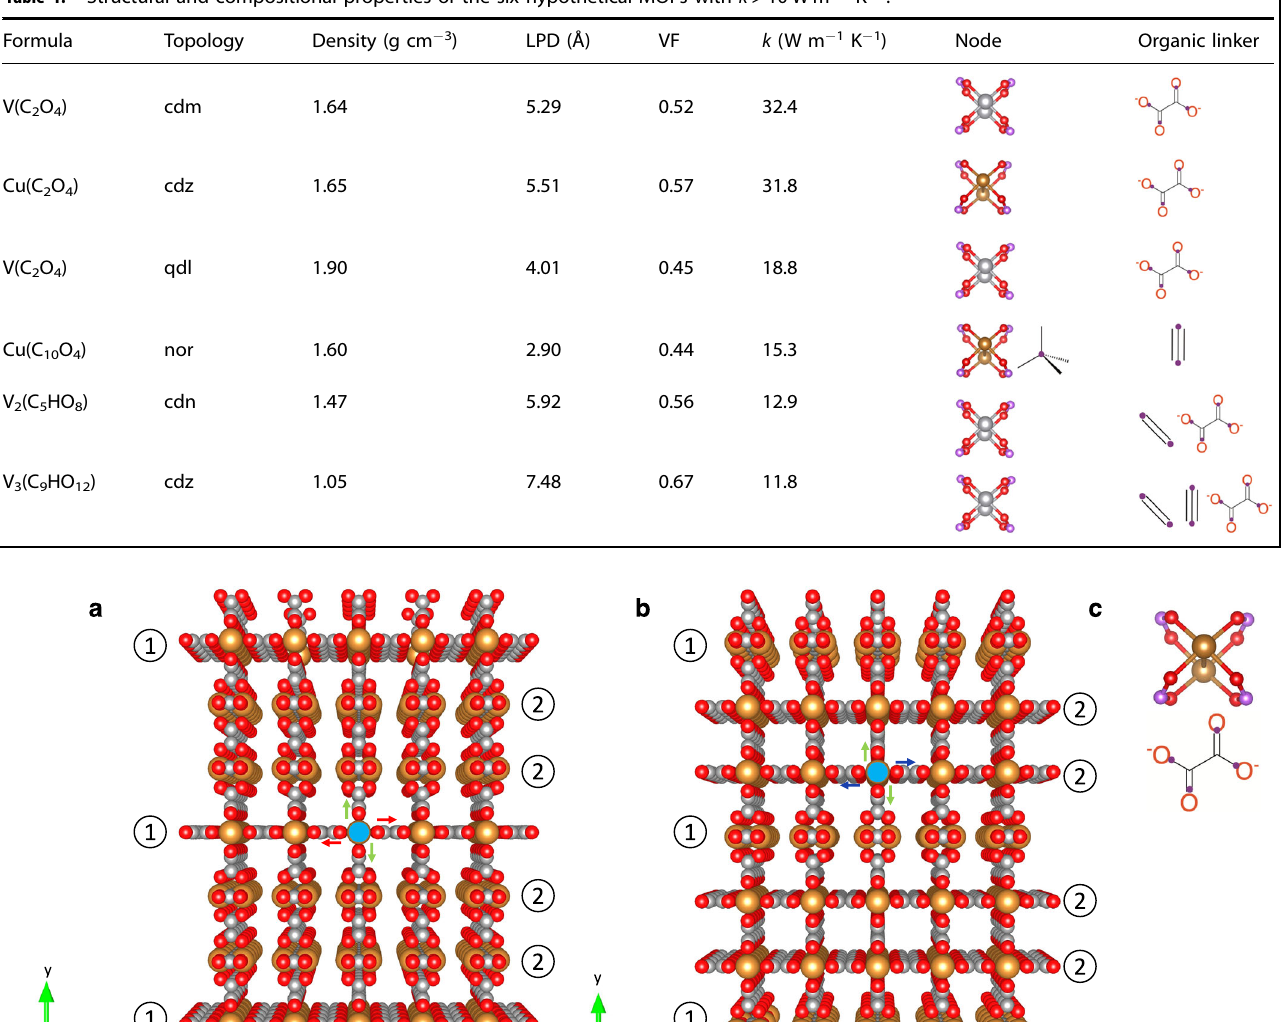
Table 1. Structural and compositional properties of the six hypothetical MOFs with k > 10 Wm − 1 K − 1 .